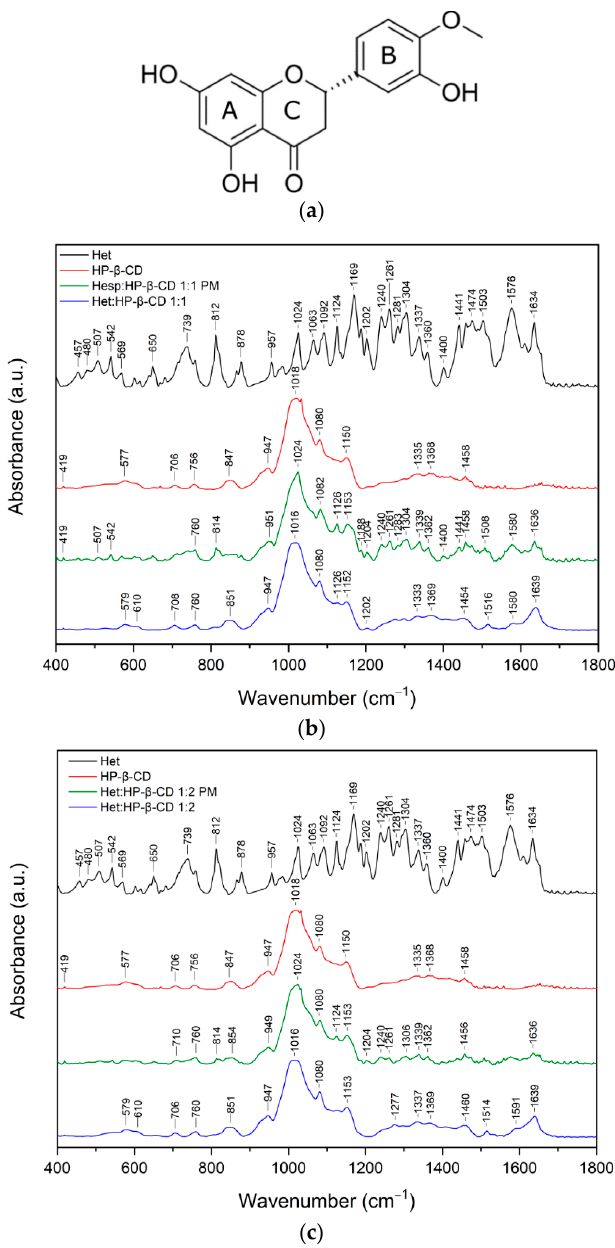
Figure 2. Structure of Het ( a ). The results of FT-IR analysis of Het (black), HP- β -CD (red), Het/HP- β -CD 1:1 physical mixture (green), Het/HP- β -CD 1:1 physical mixture (blue) ( b ), and Het (black), HP- β -CD (red), Het/HP- β -CD 1:2 physical mixture (green), Het/HP- β -CD 1:2 physical mixture (blue) ( c ); range 400–1800 cm –1 .